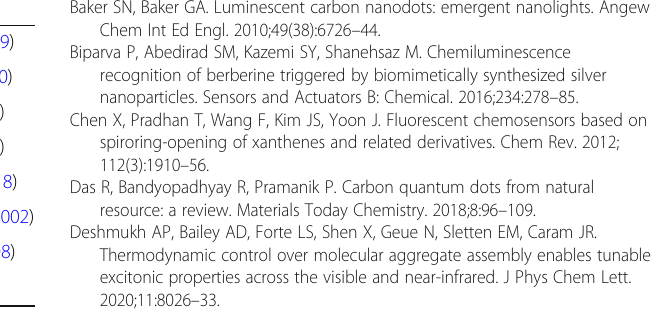
Table 2 Comparison of several typical methods for BH detection Sensor